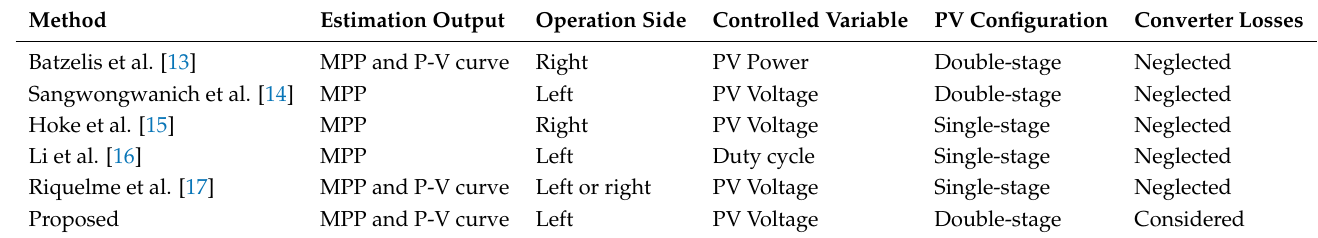
Table 1. Existing and proposed methods for estimating the maximum available power point while operating suboptimally.